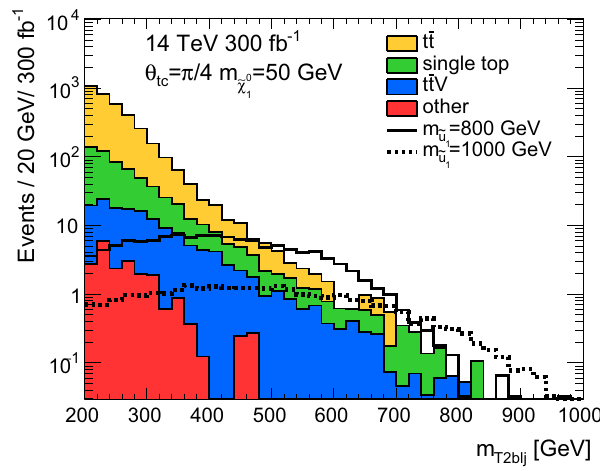
[GeV] u~ m 1 theexclusioncontourandthebottom-leftsideofthefigure.Right:signal , m ) plane for the over background ratio as a function of m ˜ u ˜ χ 0 1 1 and Case-B (blue, squares) analysis strategies when one imposes that > 550 GeV m T2 blj